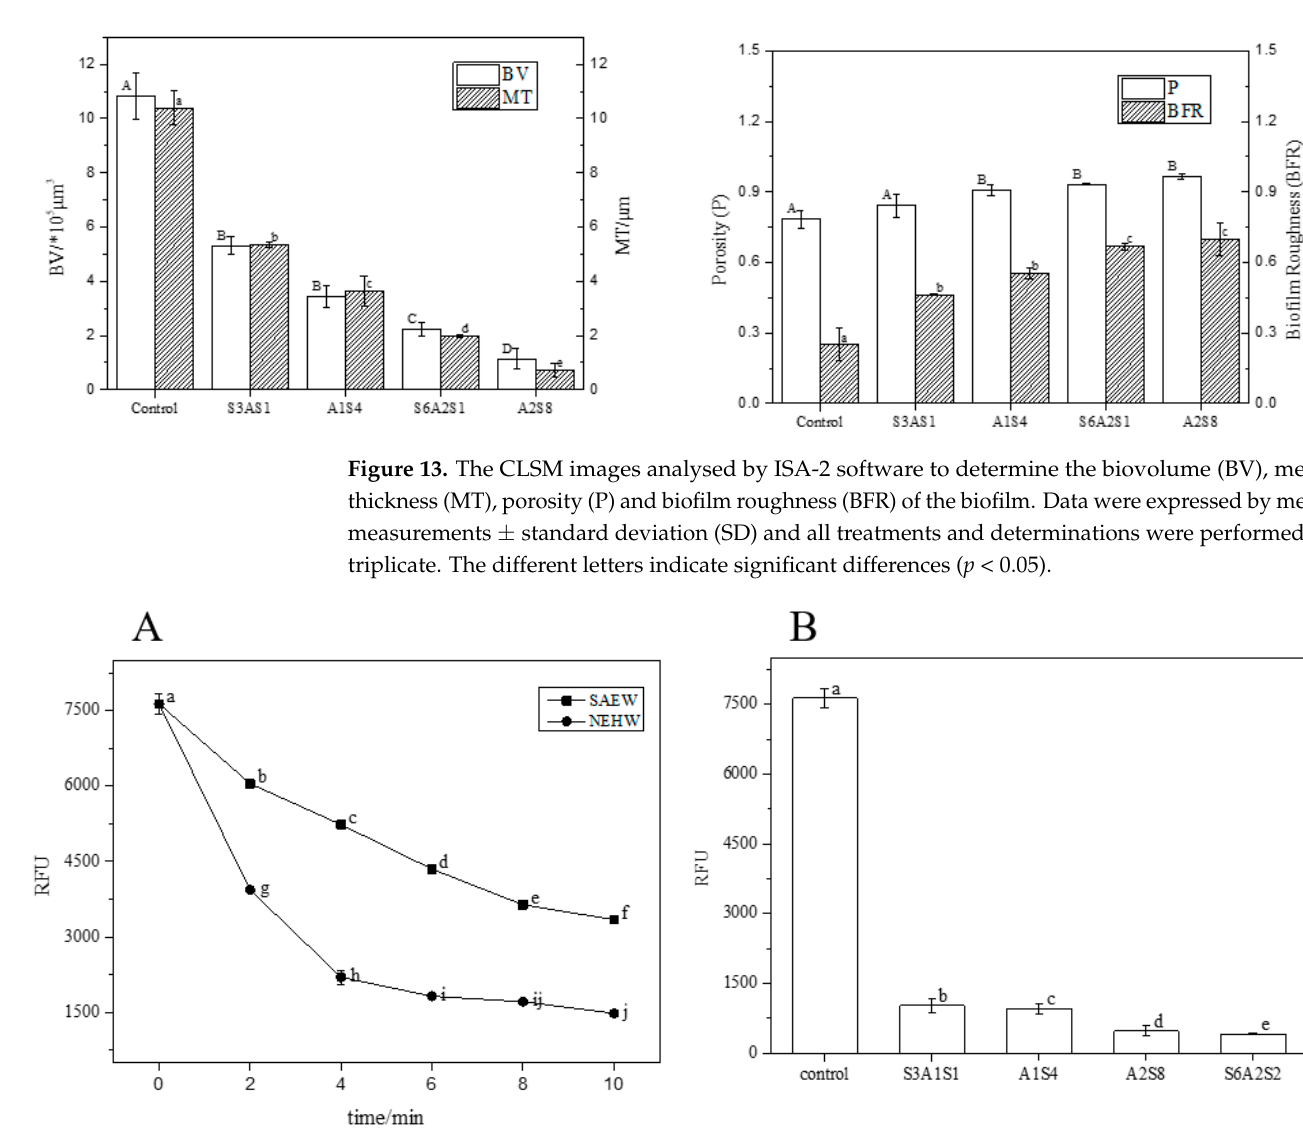
Figure 14. The RFU of residual eDNA content in each treatment. ( A ) is the RFU of residual eDNA after SAEW and NEHW treatment. ( B ) is the RFU of residual eDNA after AEW and ALEW treat- ment. The different letters indicate significant differences ( p < 0.05). Data were expressed by mean measurements ± standard deviation (SD) and all treatments and determinations were performed in triplicate.